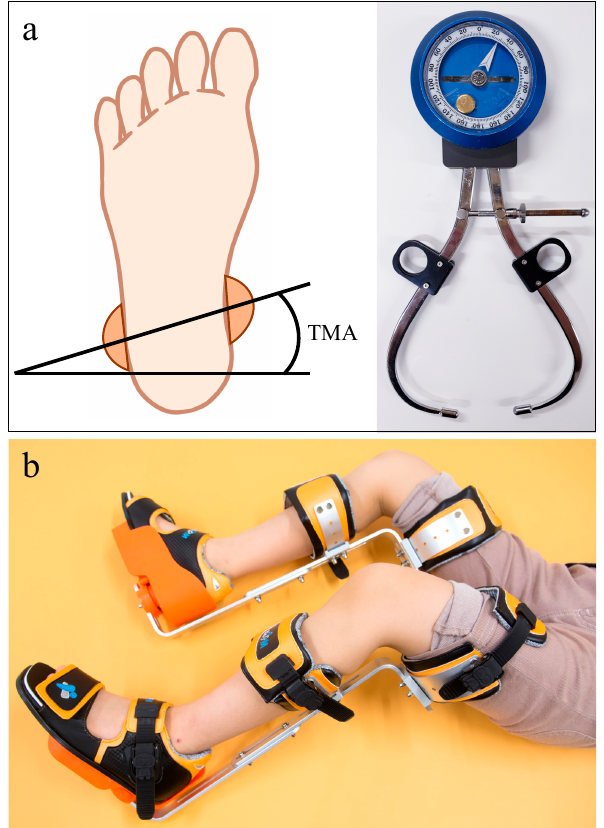
Figure 1. ( a ) A photo of a gravity goniometer and measurement of the transmalleolar angle (TMA). The TMA is the angle measured using a gravity goniometer [2,8] between the line connecting the